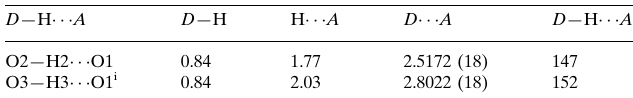
Hydrogen-bond geometry (A˚ , (cid:3)